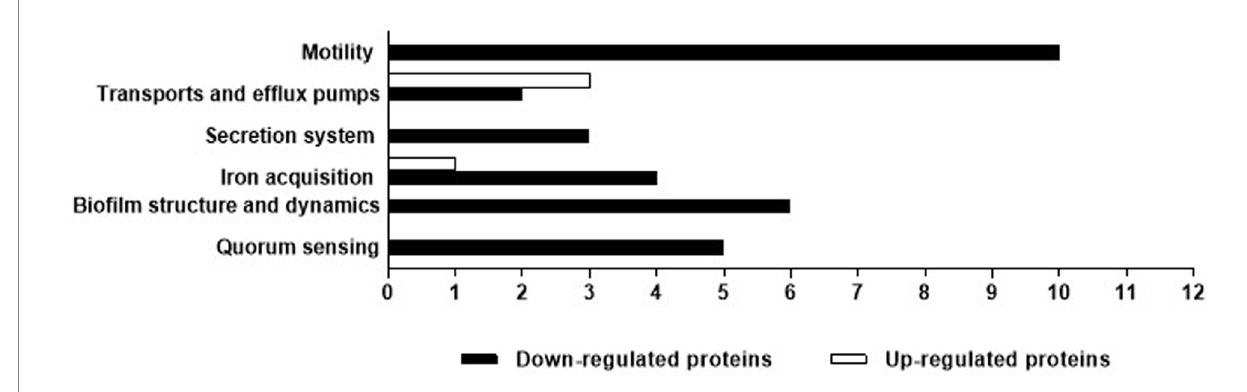
FIGURE 9 P. aeruginosa biofilm-related proteins and other virulence factors that had a significant (> 1.5-fold change) difference in production between the control and Nissle cell-free supernatant. Proteins were classified according to their